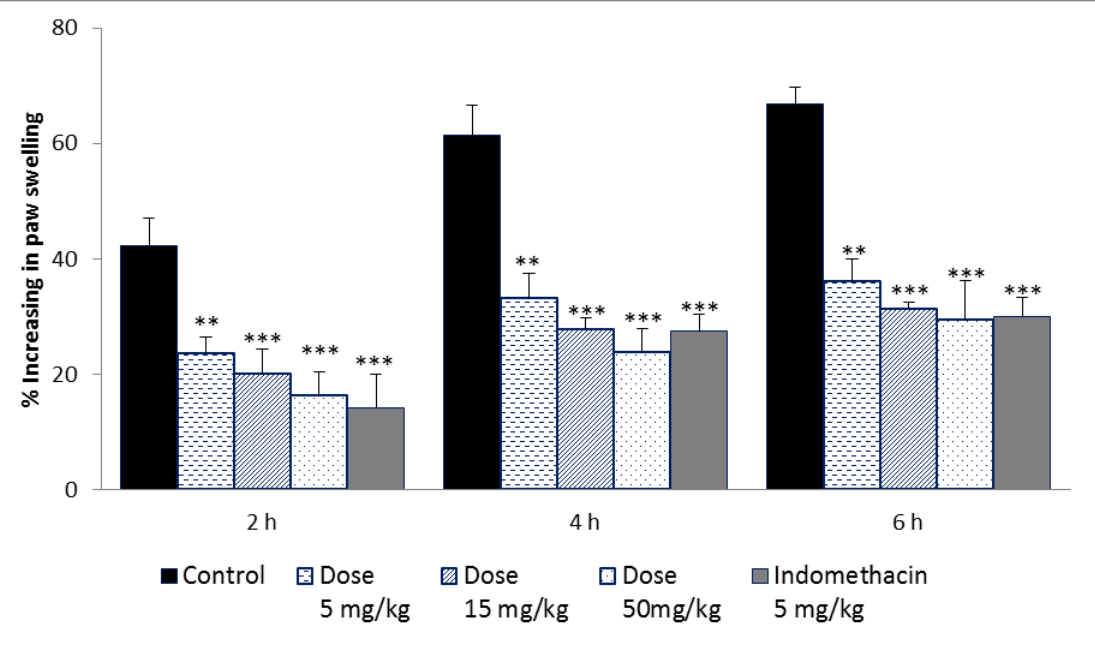
Figure 6. Effect of acetone extract from fruiting bodies of Pleurotus florida on carrageenan-induced edema in rat hind-paw. Indomethacin wad used as positive control. The values are expressed as ±SD ( n = 5). *** p ≤ 0.001; ** p ≤ 0.01 vs . control